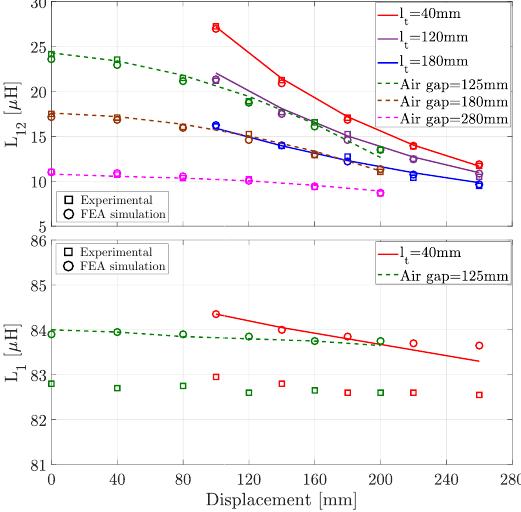
Figure 11. Comparison of the fitting approach with both experimental and FEA simulation data as a function of both vertical and lateral displacements.